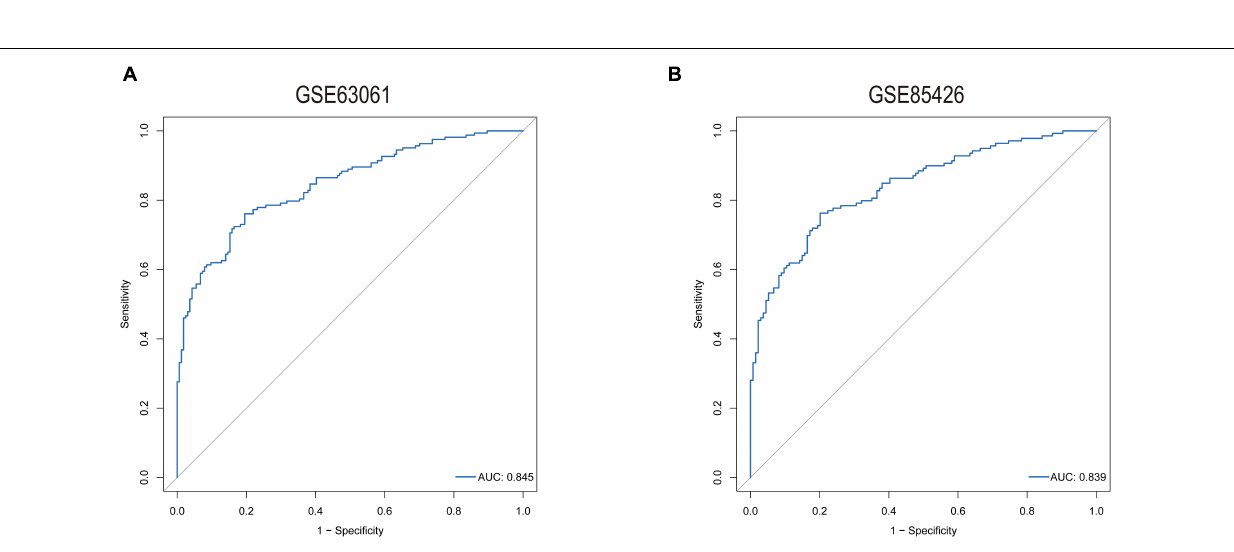
Frontiers in Genetics |